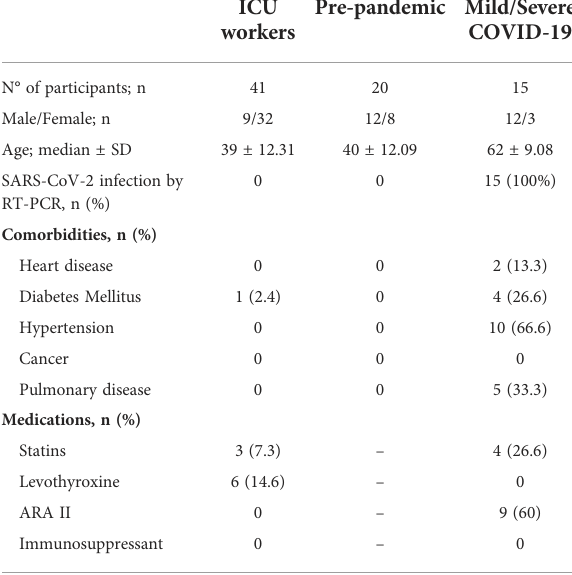
TABLE 1 Characteristics of individuals groups under study.